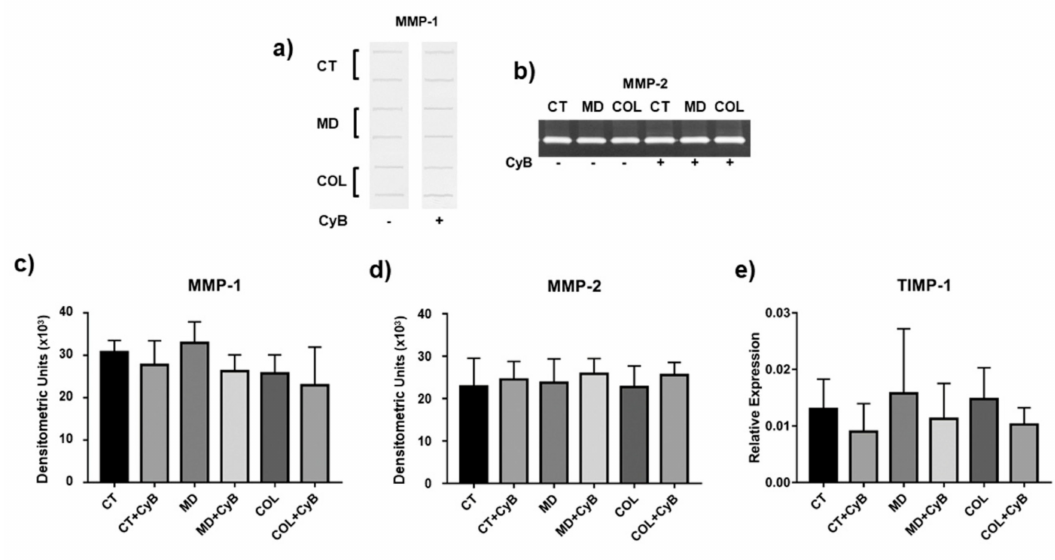
Figure 7. Representative slot blot for matrix metalloproteinase-1 (MMP-1) levels ( a ) and representative SDS-zymography showing MMP-2 activity ( b ) assayed in serum-free cell supernatants of tenocytes cultured in the considered experimental settings. Bar graphs showing MMP-1 protein levels ( c ) and MMP-2 activity ( d ) after densitometric analysis of immunoreactive and lytic bands, respectively. Data are expressed as means ± SD for at least two independent experiments. ( c , e ) Bar graphs showing TIMP-1 gene expression after normalization on GAPDH mRNA levels. Data are expressed as mean ± SD for at least two independent